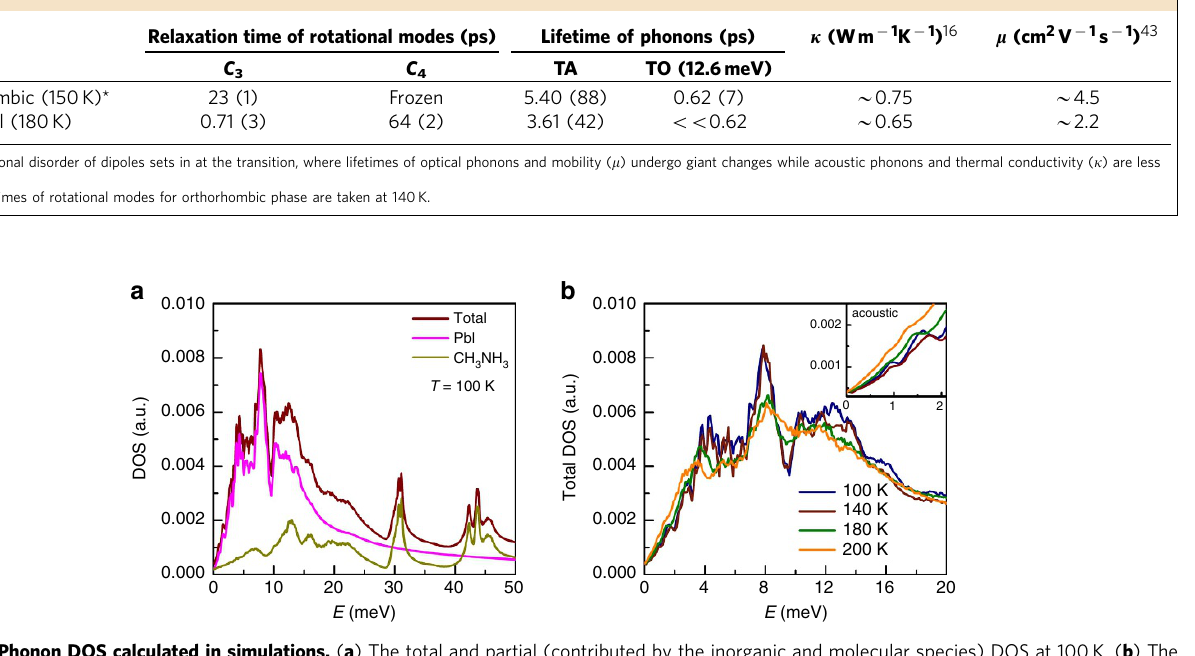
Table 3 | Timescales of atomic dynamics and related physical properties.